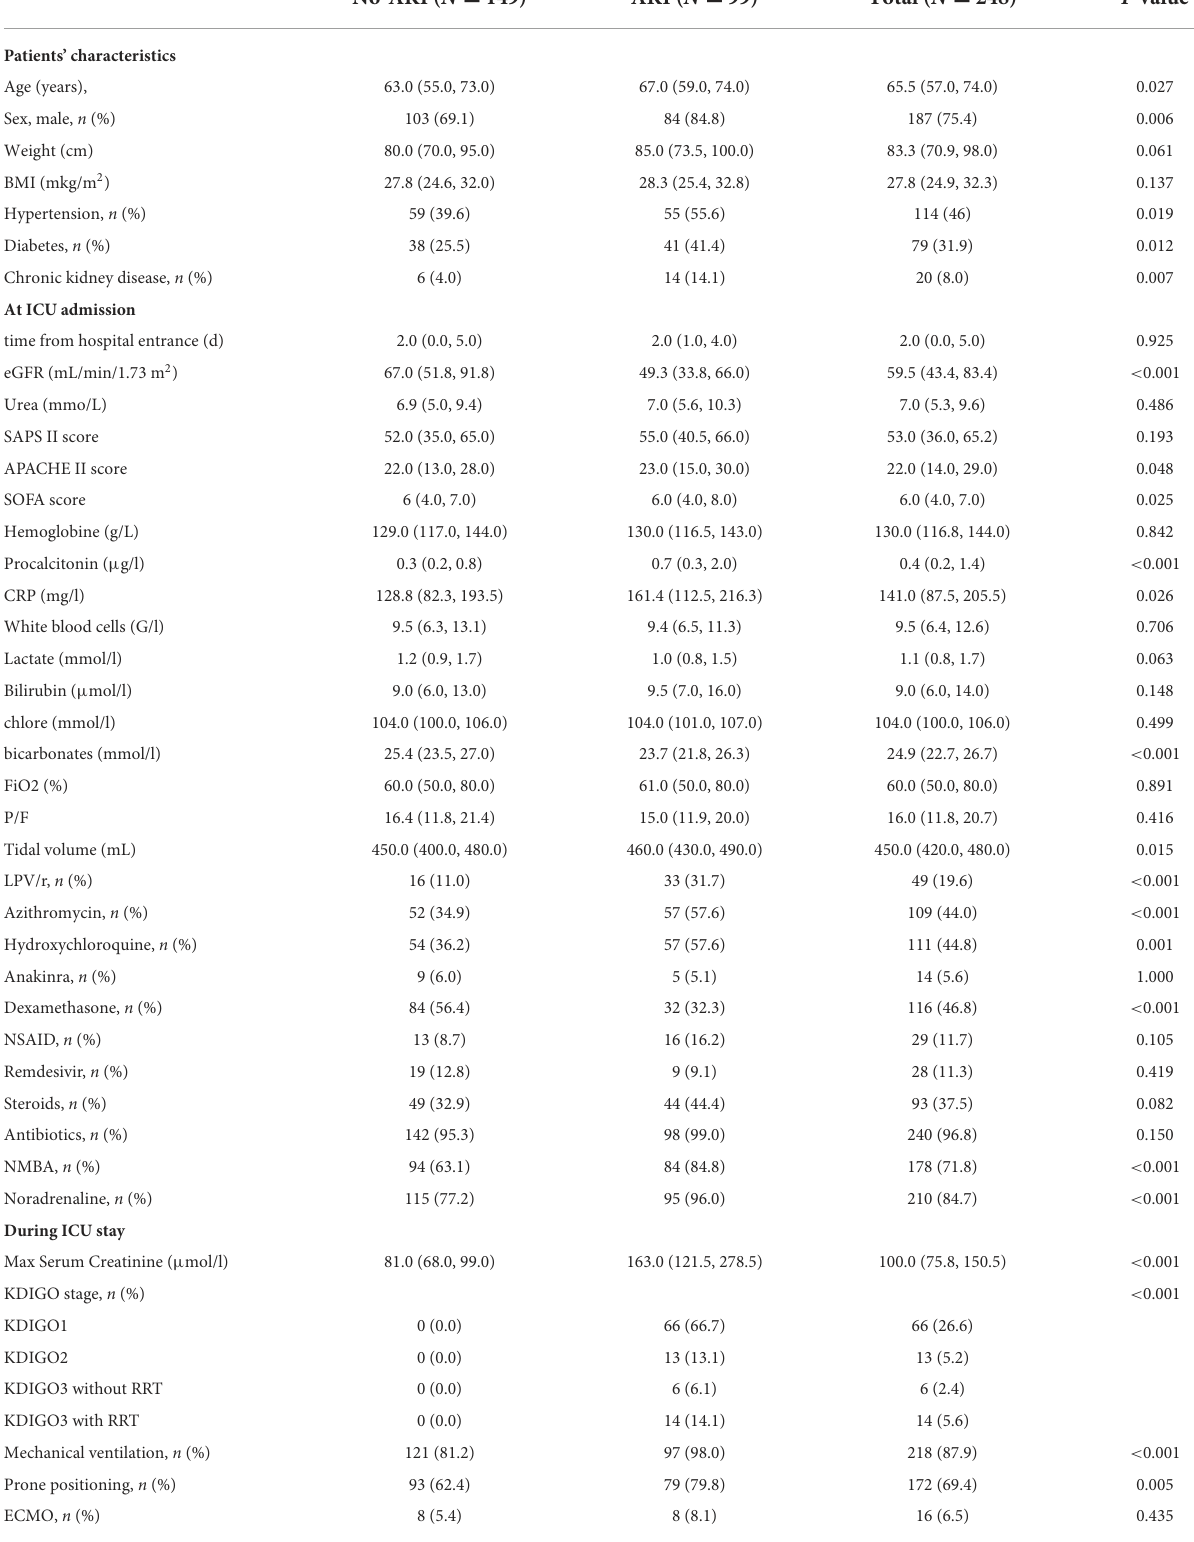
TABLE 1 Baseline characteristics: Data are presented as mean (percentage) or as median (interquartile range). No-AKI ( N = 149) P value